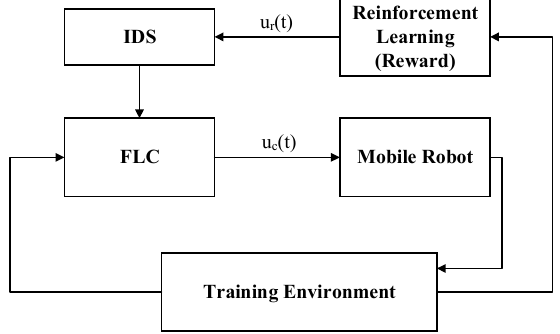
Figure 1. Architecture of the proposed FLC_R-IDS for mobile robot.